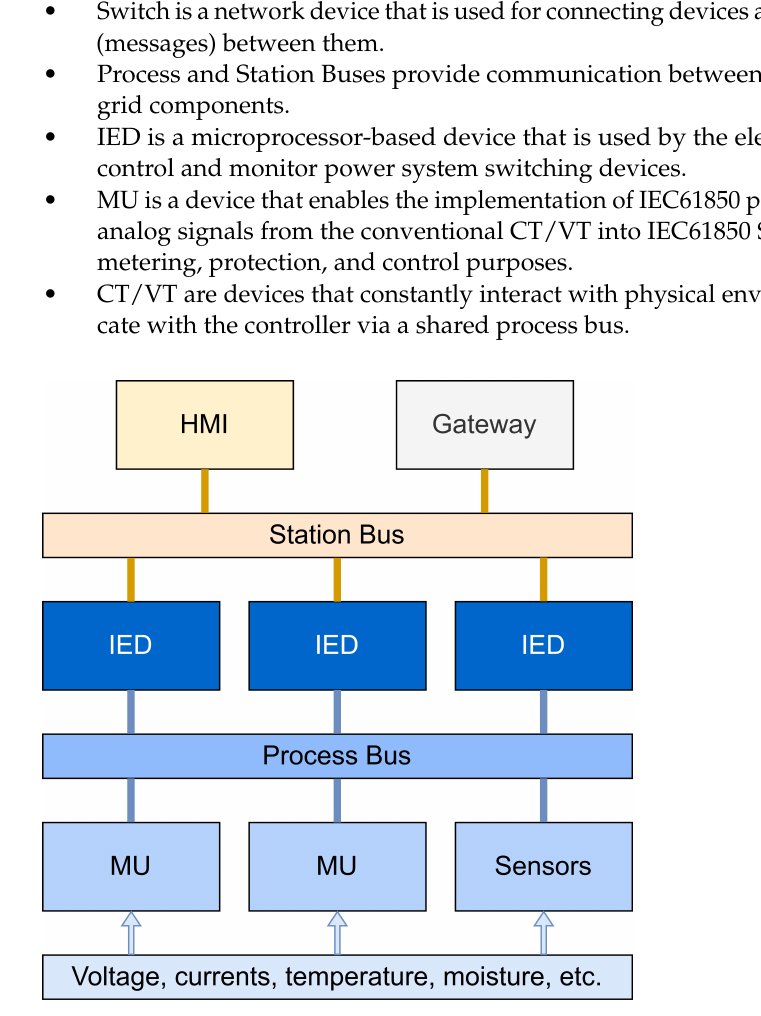
Figure 1. Digital Substation